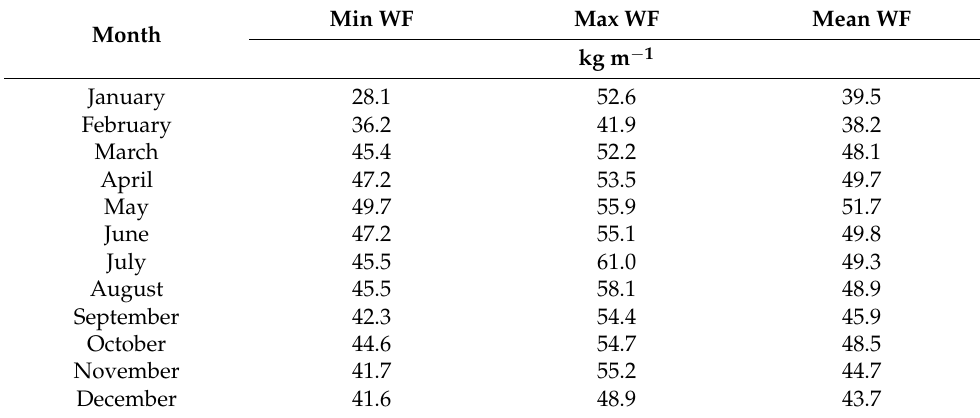
Table 3. Modelled monthly descriptive statistics (minimum, maximum, mean) of the weather factor (WF) of the revised wind erosion equation for the study region.